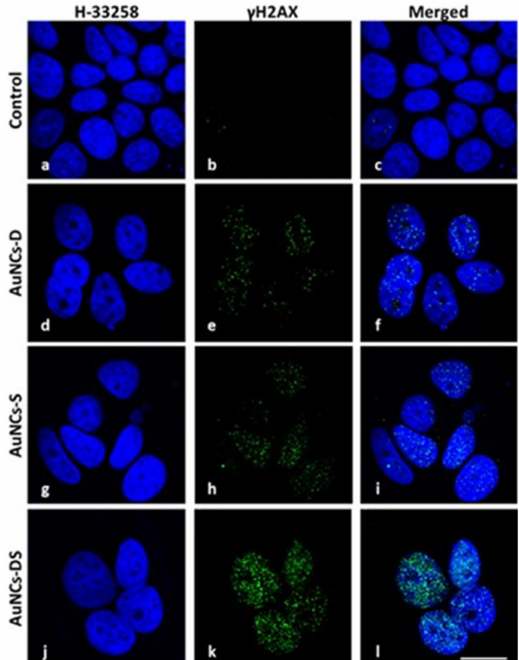
Figure 7. DNA damage study against histone γ H2AX. γ H2AX fluorescence pattern (green) was observed at the confocal microscope at 48 h after incubation with di ff erent AuNCs. MCF-7 cells were fixed and processed for γ H2AX immunofluorescence, DNA was counterstained with Hoechst-33258 (blue) and both images were overlapped. ( a – c ) Control cells. ( d – f ) Cells pre-incubated with AuNCs-D. ( g – i ) Cells pre-incubated with AuNCs-S. ( j – l ) Cells pre-incubated with AuNCs-DS. Scale bar: 7.5 µ m.